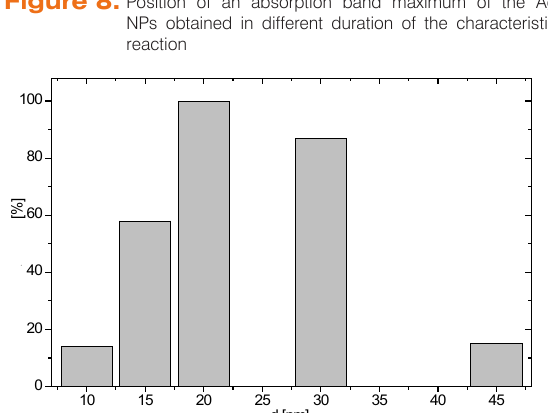
Figure 9. Volumetric size distribution of resultant silver nanoparticles obtained using the charasteristic reaction.